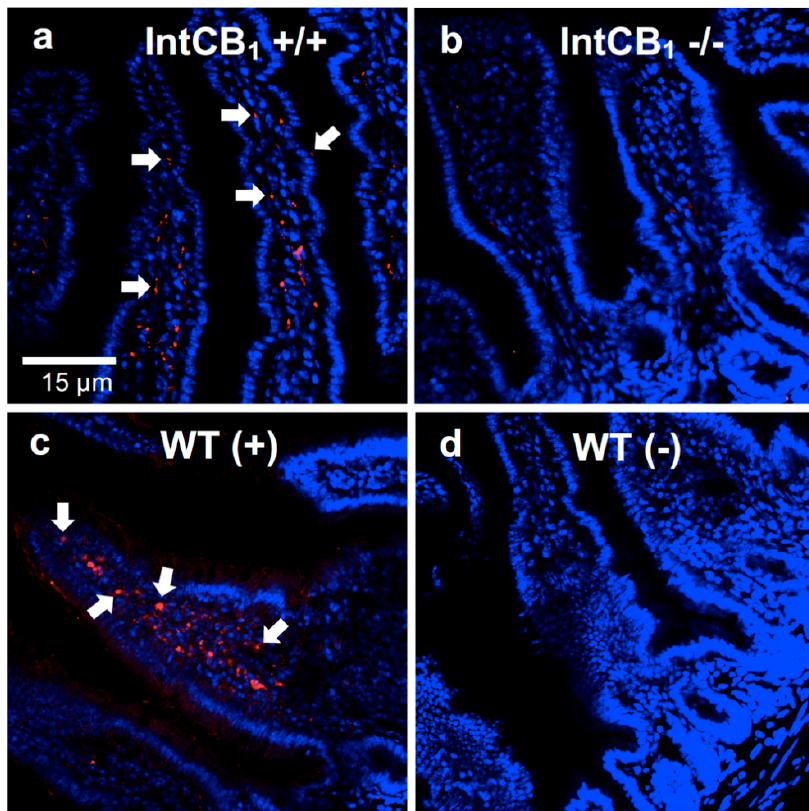
Figure 2. CB 1 R immunoreactivity is absent in the upper small-intestinal epithelium of conditional intestinal epithelium-specific CB 1 R-deficient mice. When compared to control mice ( a , IntCB +/+), conditional intestinal epithelium-specific CB 1 R-null mice ( b , IntCB 1 − / − ) are deficient in immunoreactivity for CB 1 Rs in the upper small-intestinal epithelium. Wild-type C57BL/6Tac mice display immunoreactivity for CB 1 Rs in the upper small-intestinal epithelium ( c , WT (+)), which is absent when the primary CB 1 R antibody is not included ( d , WT(-)). White arrows point to representative red immunoreactivity for CB 1 Rs. Red = CB 1 R immunoreactivity; blue = DAPI. WT = wild-type mice. (+) = with CB 1 R primary antibody; (-) = without CB 1 R primary antibody. CB 1 R deficiency in the intestinal epithelium of IntCB 1 − / − mice was further confirmed by qRT-